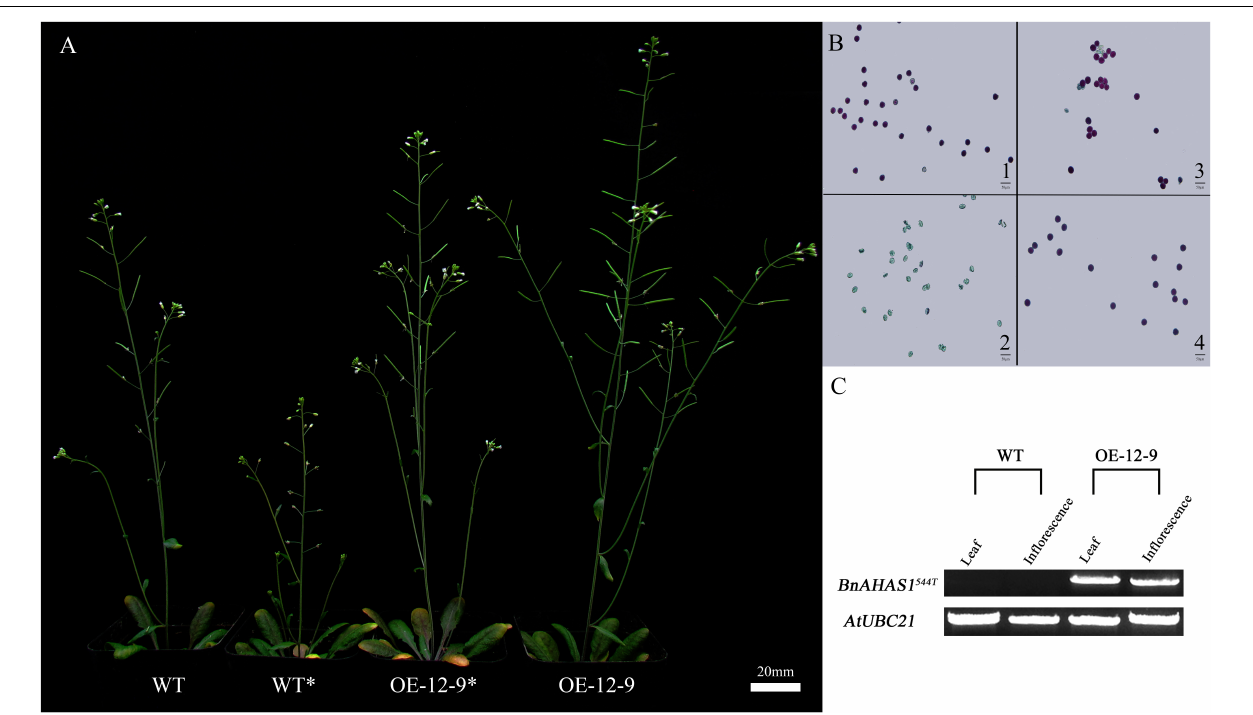
FIGURE 5 | Over-expression of BnAHAS1 544 T increases TBM-resistance in Arabidopsis . (A) Phenotypes of plants treated with 0 and 0.007 mg · L − 1 tribenuron-methly (TBM). WT and WT ∗ represent wild type plants treated with 0 and 0.007 mg · L − 1 TBM, respectively. OE-12-9 and OE-12-9 ∗ indicate transgenic lines treated with 0 and 0.007 mg · L − 1 TBM, respectively. (B) Pollens viability of Arabidopsis plants. 1 and 2, wild type plants treated with 0 and 0.007 mg · L − 1 TBM, respectively; 3 and 4, transgenic line OE-12-9 treated with 0 and 0.007 mg · L − 1 TBM, respectively; bars = 50 µ m. (C) Over-expression level of BnAHAS1 544 T in WT and OE-12-9